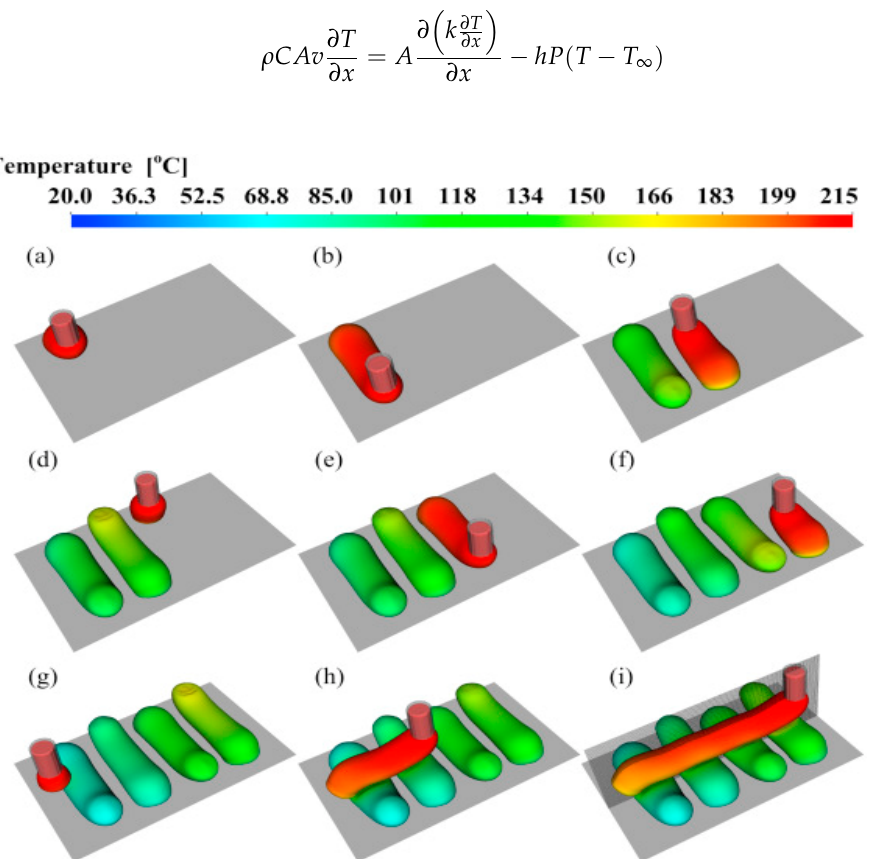
Figure 7. Temperature profiles for simulated printed beads in multi-layer deposition. ( a – i ) frames in time order, from the simulation of printing three filaments in parallel. Reprinted with permission from reference [49]. Copyright 2019,